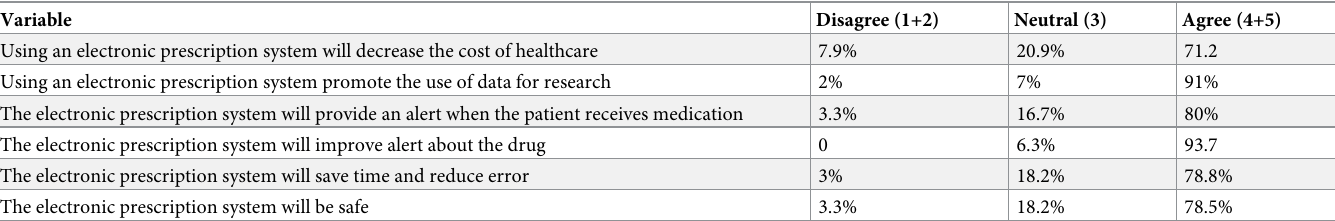
Table 3. Perception of physicians towards perceived usefulness of electronic prescription system (N =